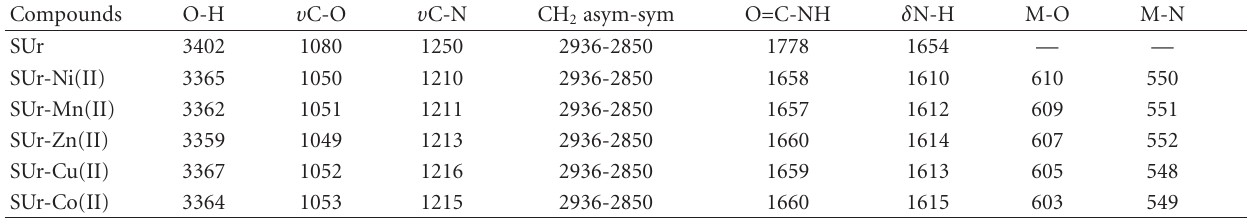
Table 2: IR bands of polymeric resin (SUr) and its polymer metal